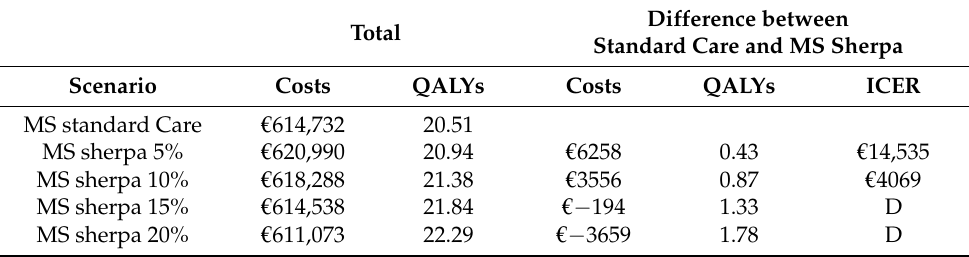
Table 1. Cost-effectiveness results of MS sherpa versus standard care from a societal perspective.